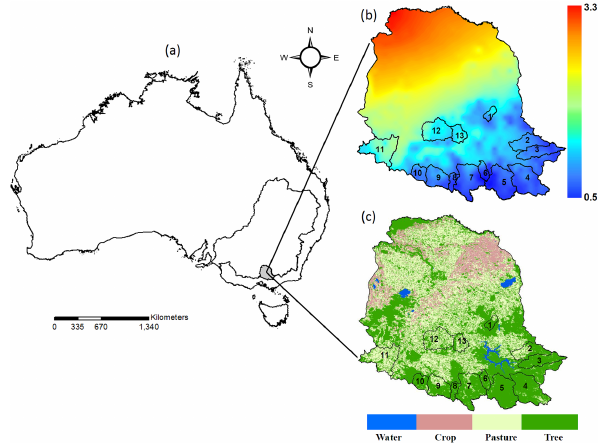
Figure 1. Location map of the study area (a) , dryness index (mean annual reference evapotranspiration divided by mean annual precip- itation) (b) and land cover type (c)